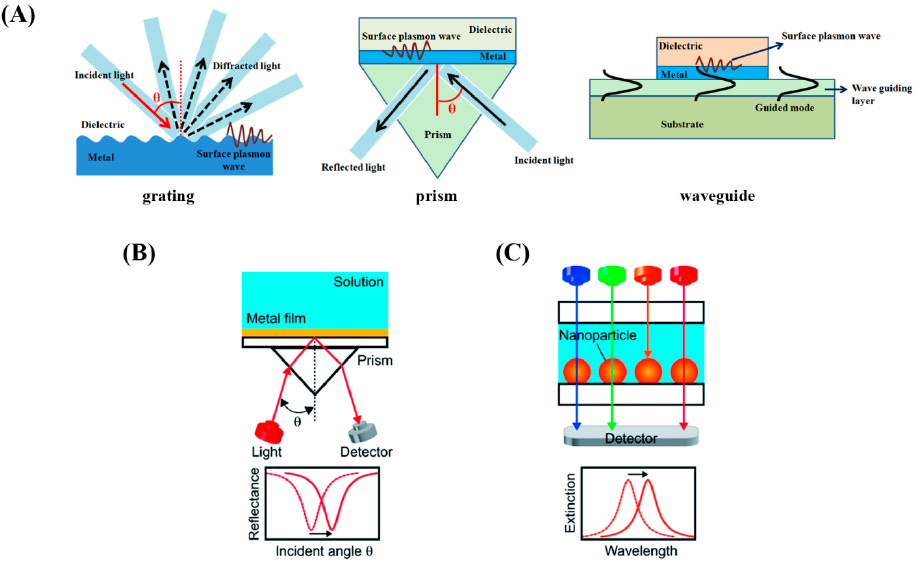
Figure 14. ( A ) The schematics display grating-, prism-, waveguide-based light coupling configurations of SPR. Reproduced with permission from Ref. [113] Copyright (2016) MDPI; ( B , C ) The illustrations show ( B ) a prism-based SPR sensor and its signal typically measured in terms of the change in the resonance angle and ( C ) a LSPR sensor detecting shifts in a spectral peak. Reproduced with permission from Ref. [114] Copyright (2014) Royal Society of Chemistry.